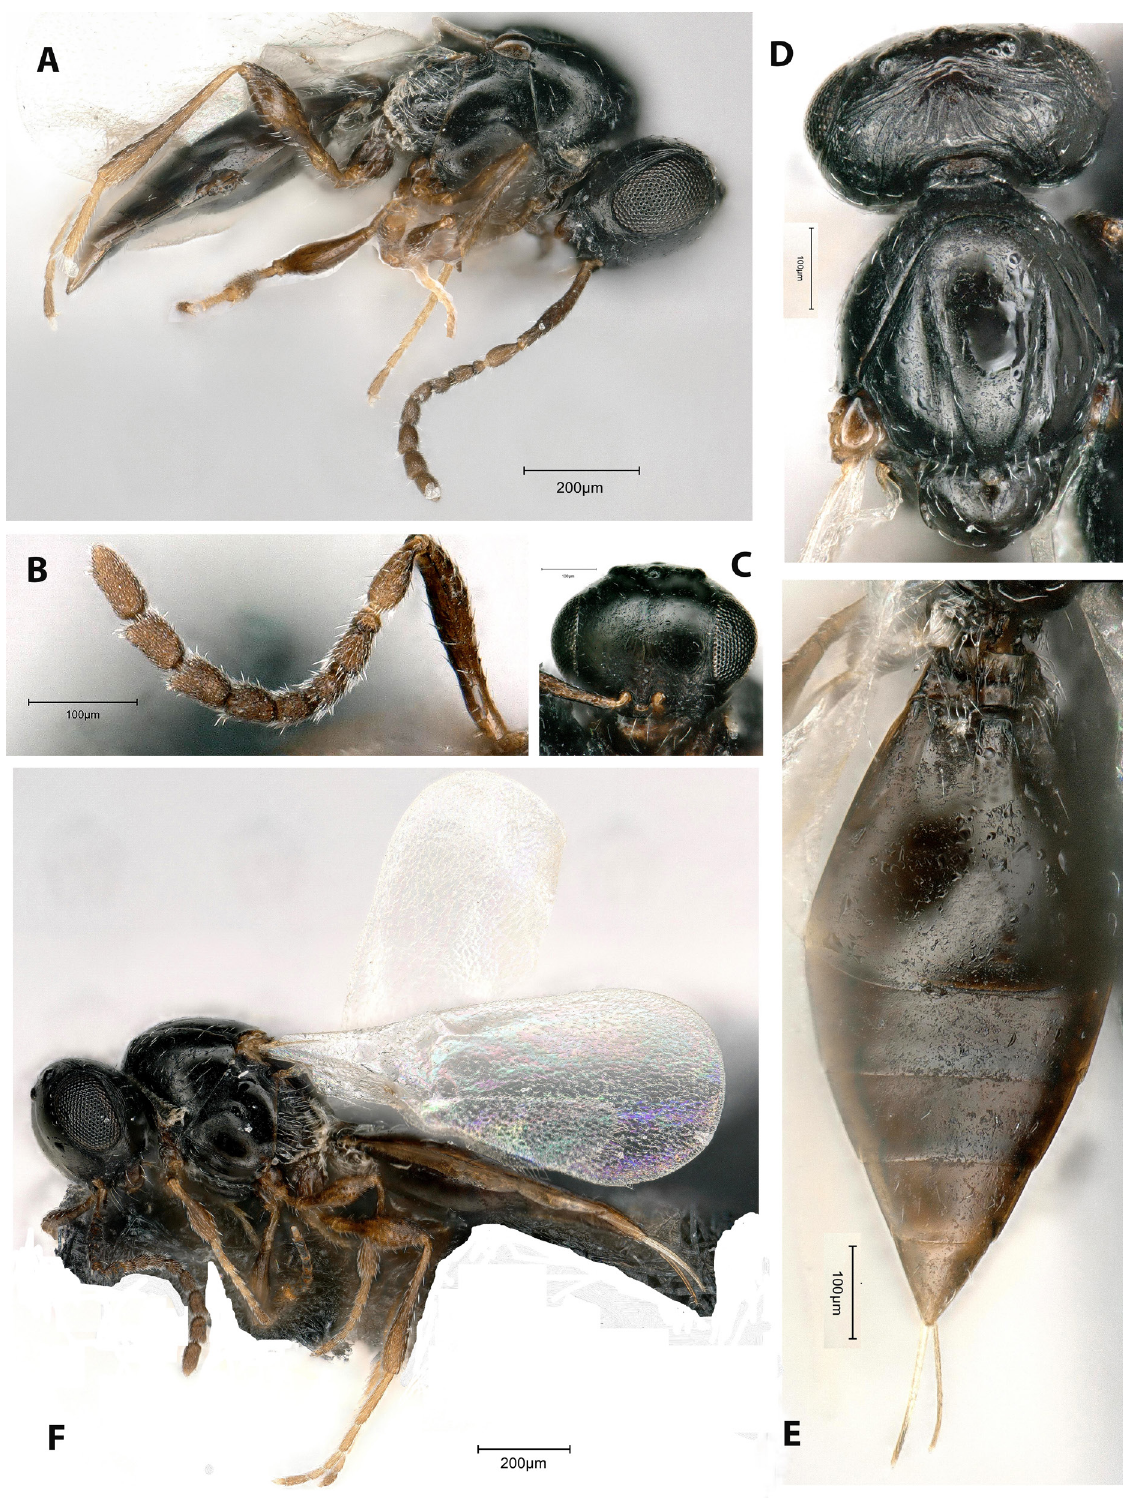
Fig. 3. Platygaster lotfalizadehi Buhl & Asadi sp. nov., ♀; A = holotype (HMIM); B–F = paratype (HMIM). A . Habitus in lateral view. B . Antenna. C . Head in frontal view. D . Head and mesonotum in dorsal view. E . Metasoma in dorsal view. F . Habitus in lateral view. Scale bars: A, F =200 µm; B–E = 100